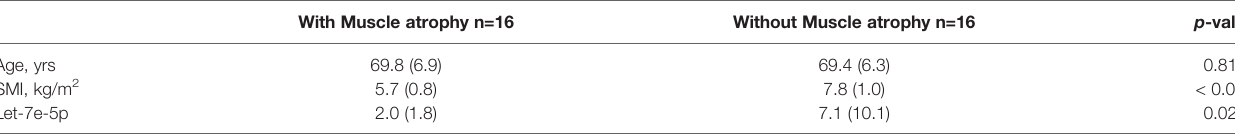
Data are mean (SD). SMI: skeletal muscle mass